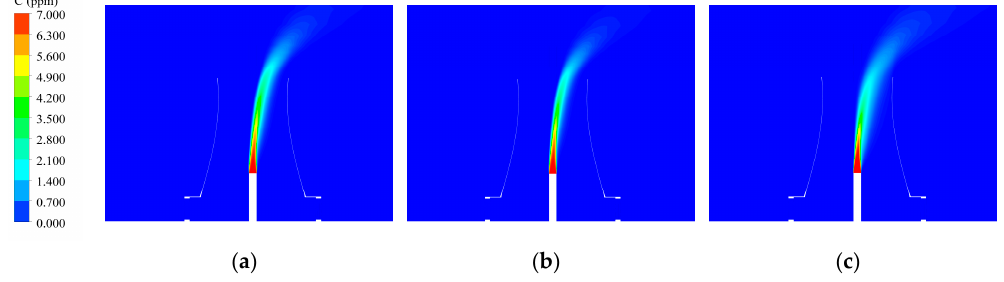
Figure 12. Comparisons of the pollutant concentration distribution at vertical plane (y = 0 m) of cooling tower: ( a ) RANS; ( b ) URANS; ( c ) LES.